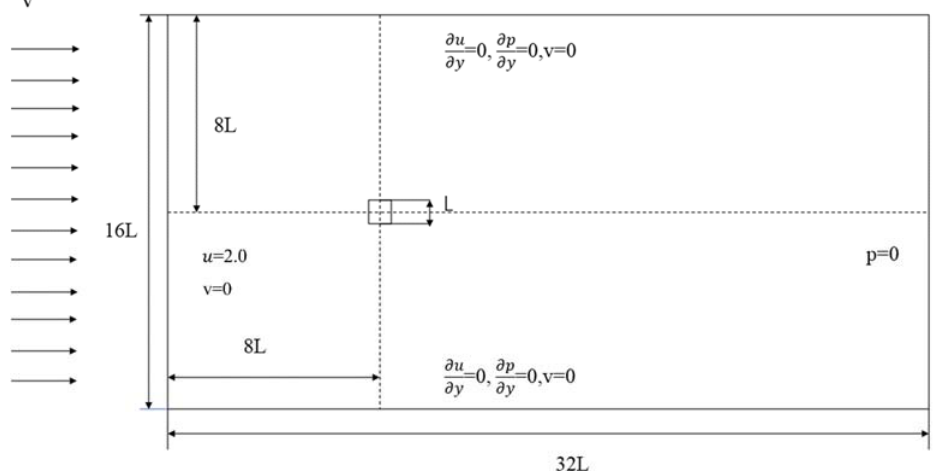
Figure 2. Simulation domain of flow over a square object.